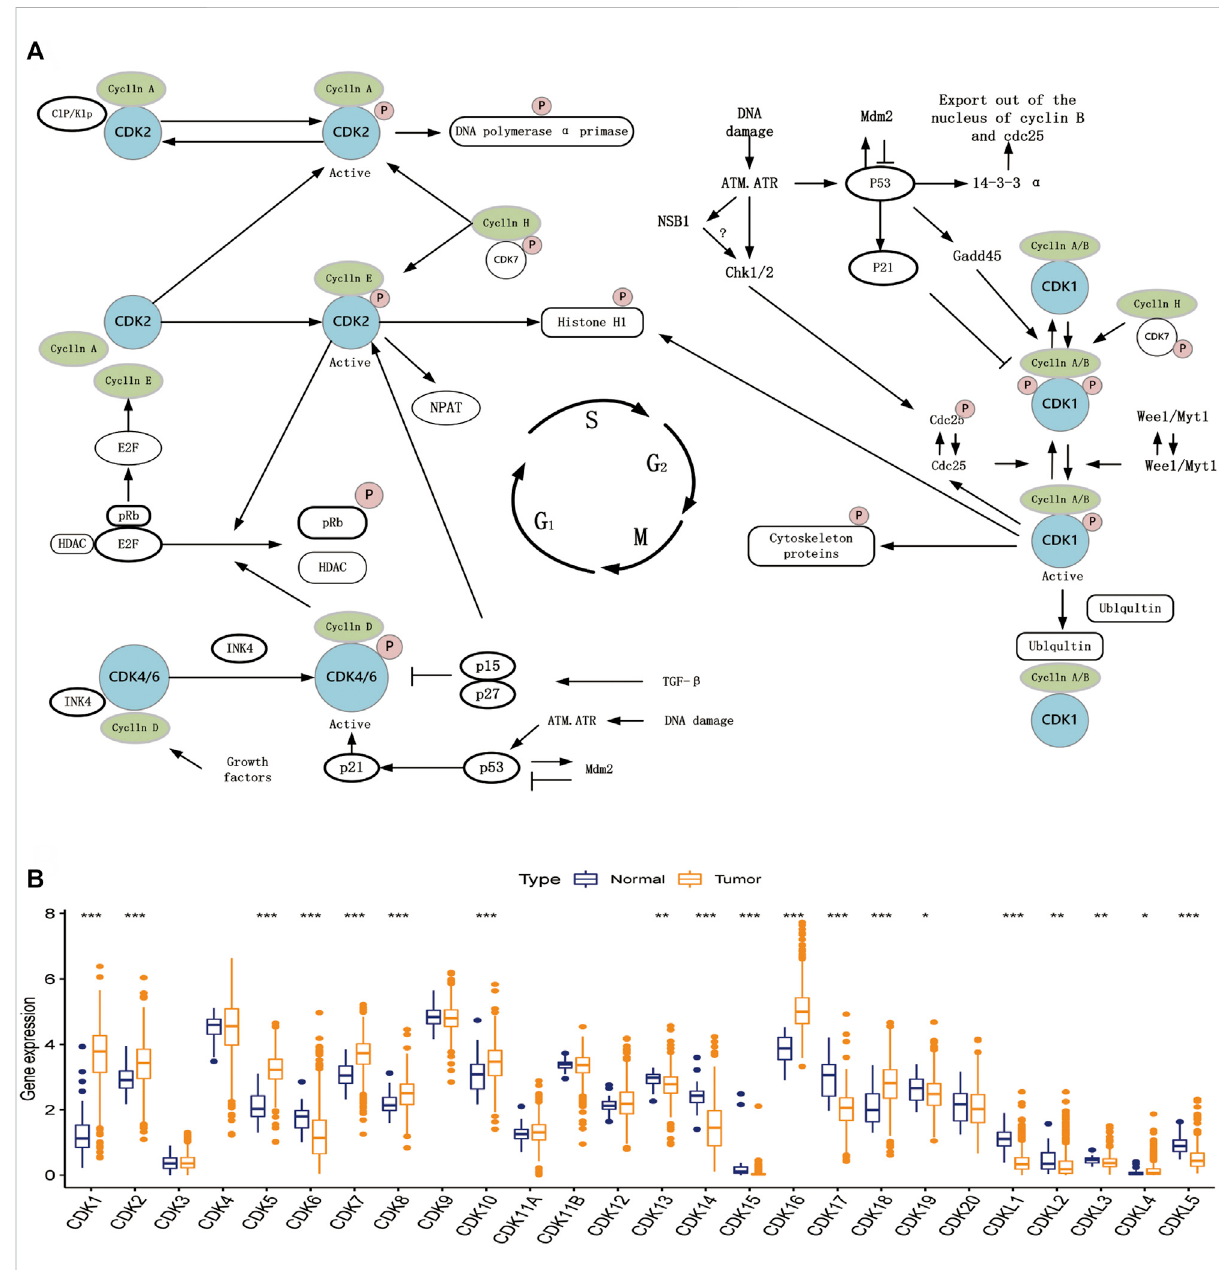
FIGURE 1 Cell cycle regulation steps and expression of CDK family genes. (A) Schematic diagram of some basic steps in cell cycle regulation. (B) Expression of 26 CDK family genes in normal endometrial tissue (dark blue) and tumor tissue (dark yellow). Box plots indicate the interquartile range of values. The rows in the boxes indicate median values and the asterisks above indicate p -values (* p < 0.05,** p < 0.01,*** p <